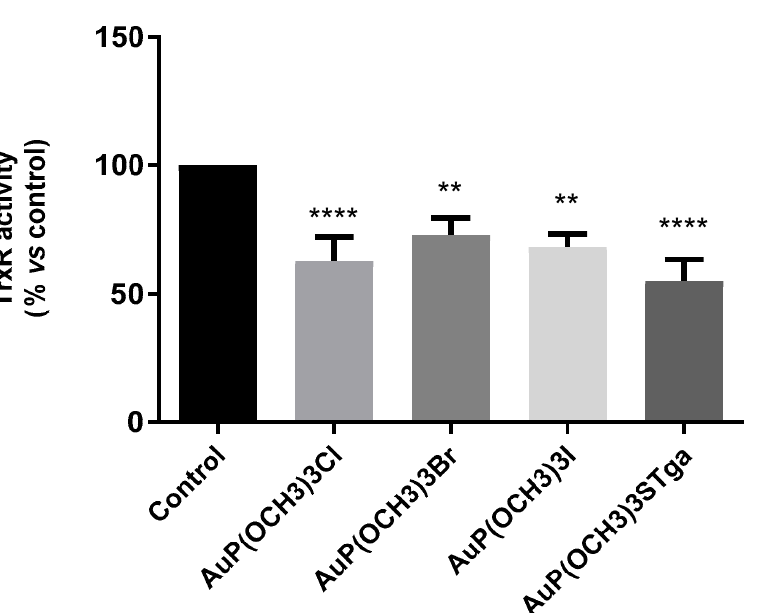
Figure 7. TrxR enzyme inhibition assay was performed after 24 h of treatment using a commercial thioredoxin reductase assay kit, whereby histograms report the residual TrxR enzyme activity in gold-treated cells expressed in percentage with respect to control cells. The analysis was performed in triplicate. The statistical analysis was carried out using one-way ANOVA test followed by Tukey’s multiple comparisons test using Graphpad Prism software v 6.0 (** p < 0.01, **** p <